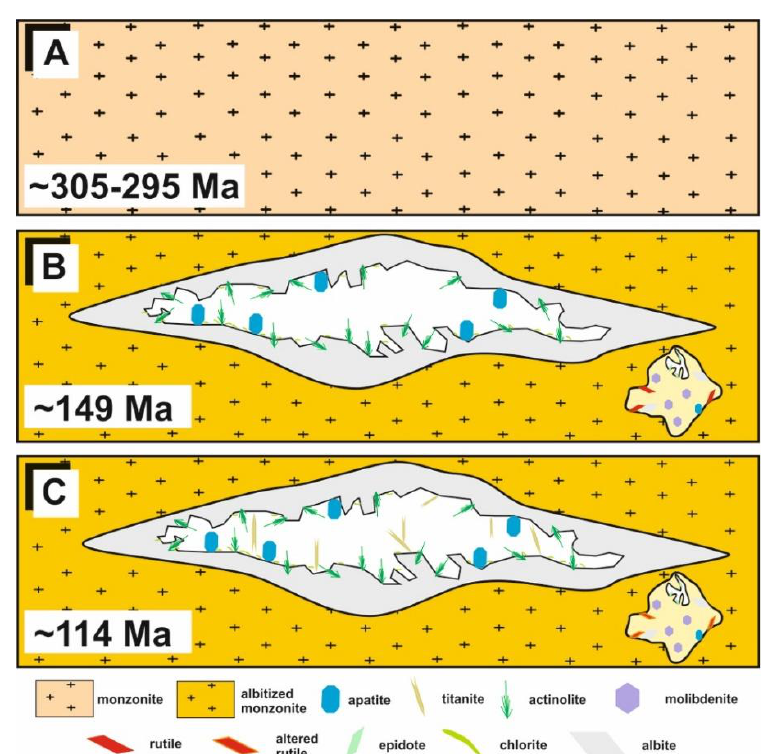
Figure 6. Simplified model of the hydrothermal activity in the Sakar Unit of Southeastern Bulgaria, based on the geochronological data presented in this study and field observations. ( A ) Formation of the Variscan host rock (~305–295 Ma). ( B ) The first, older hydrothermal event forms the primary mineralization (ca. 149 Ma. ( C ) The second, younger hydrothermal episode forms titanite (ca. 114 Ma age).